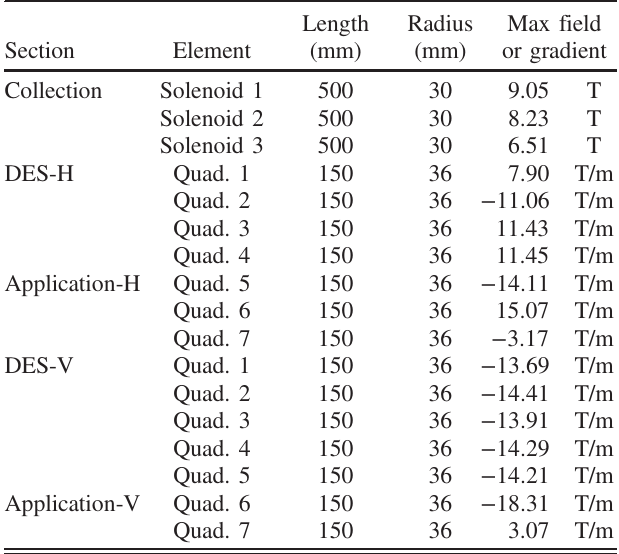
TABLE III. Main parameters for the focusing elements of the beam transmission